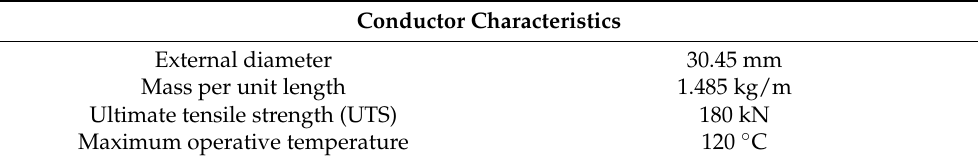
Table 2. Main characteristics of the conductor employed in the